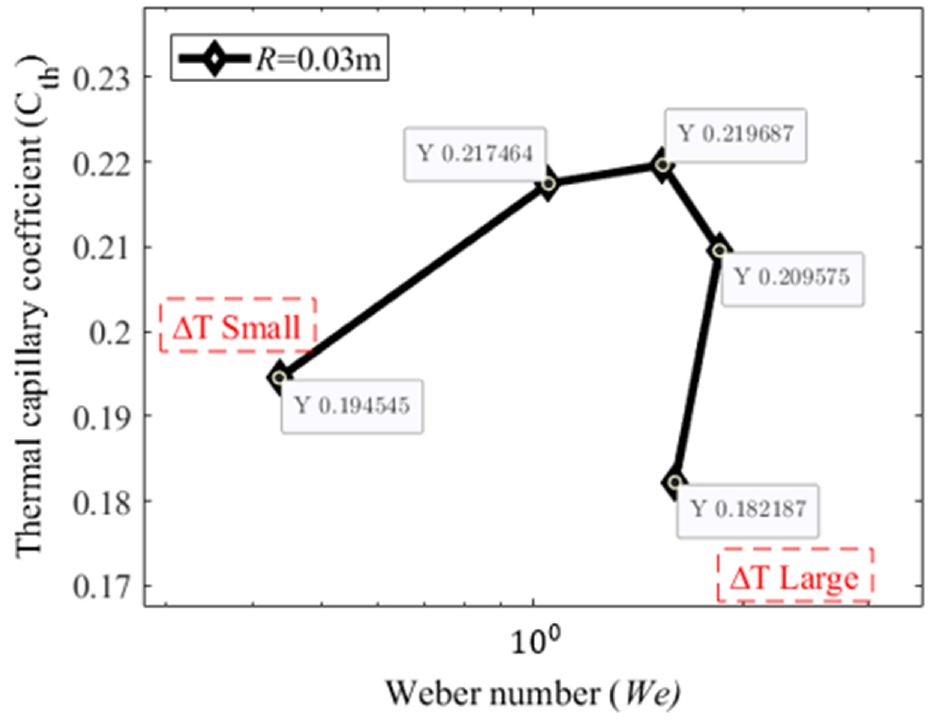
Figure 13. Thermo-capillary coefficient ( C Th ) vs. the Weber number ( We ) for R = 0.03 m.